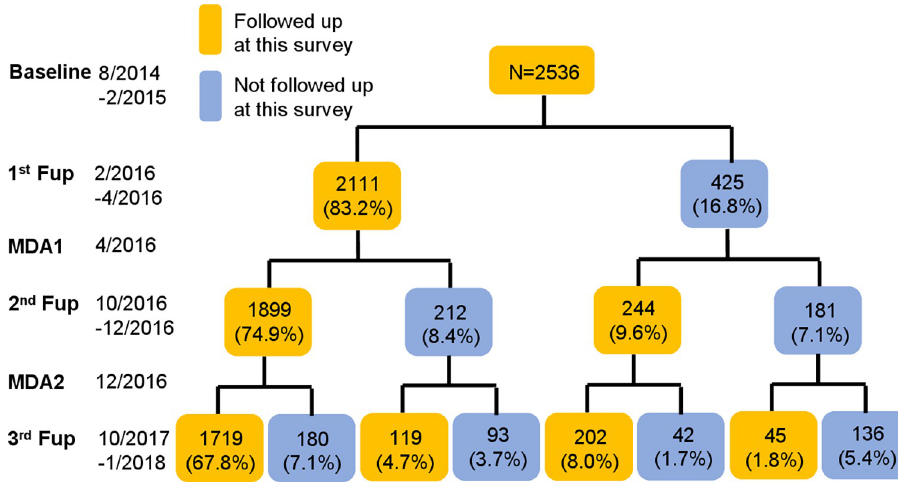
Fig 1. Flow chart of study participants. The denominator of the percentages is N = 2536. Follow up is denoted as Fup.